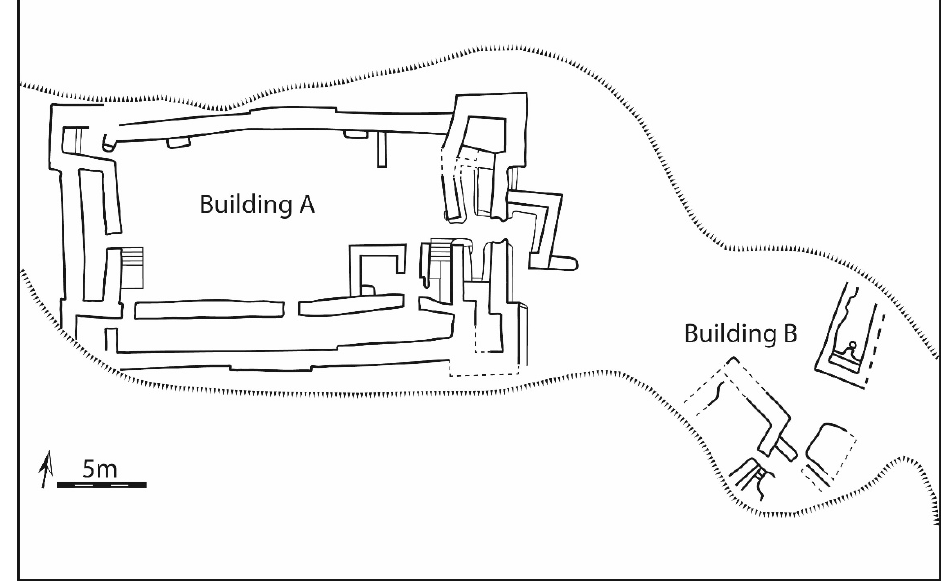
Figure 3. General plan of Kuntillet ˁ Ajrud (after Meshel 2012, Fig. 2.1).